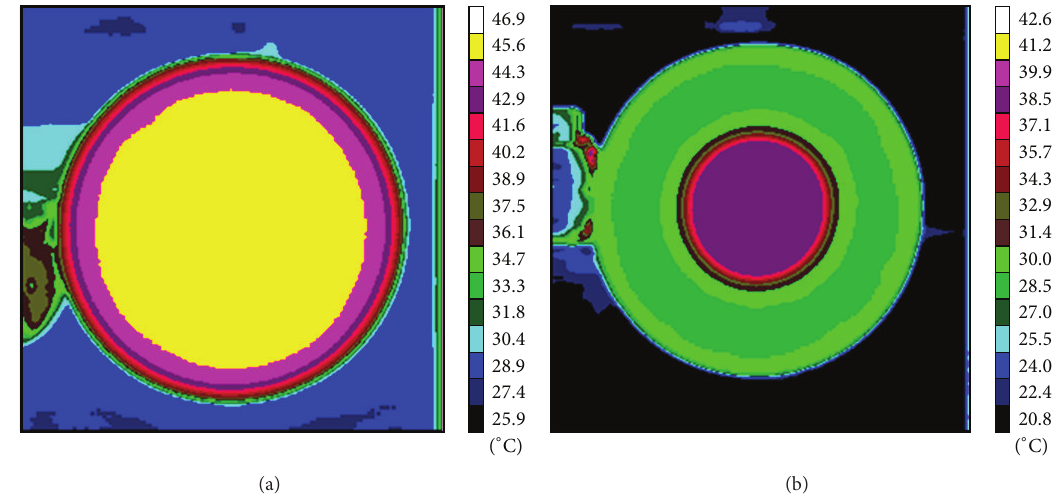
Figure 4: Temperature map ( ∘ C) of the rotating disk for 𝑇 𝑎 = 21.4 ∘ C: (a) 𝜔 = 576 rpm, 𝑞 = 515 W/m 2 ; (b) 𝜔 = 4390 rpm, 𝑞 = 871 W/m 2 .